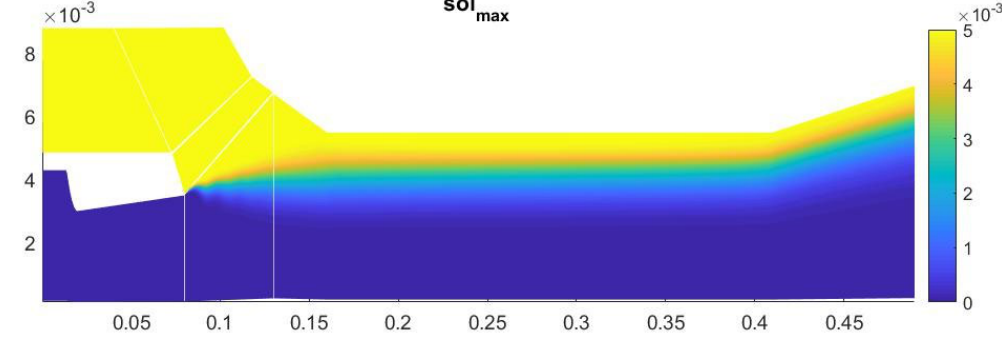
Figure 11. Solid particle concentration distribution.